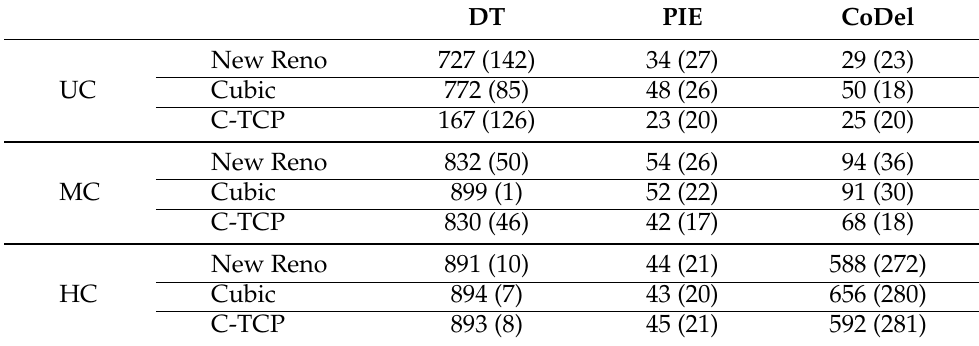
Table 8. Mean queue length and standard deviation of queue length [pkts] in the Access Link scenario with common TCPs, UC—uncongested, MC—mildly congested, HC—heavily congested network. DT PIE